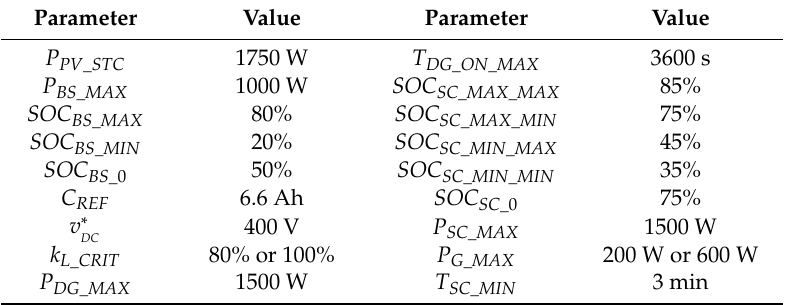
Table 1. General